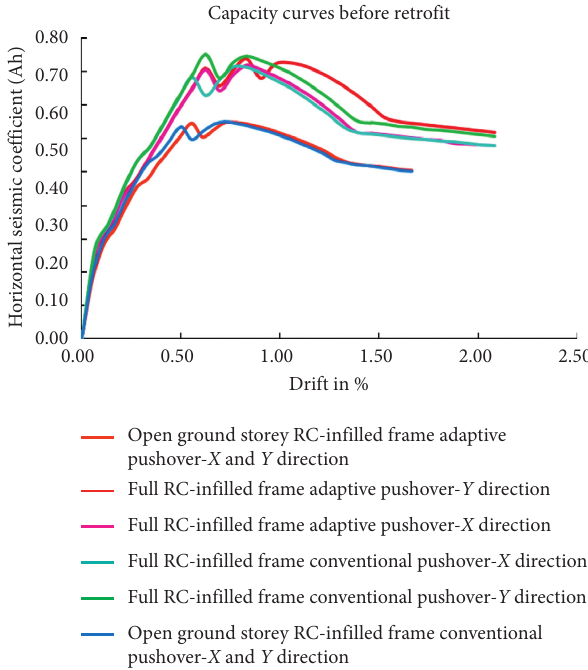
Figure 17: Pushover curves of different frames after